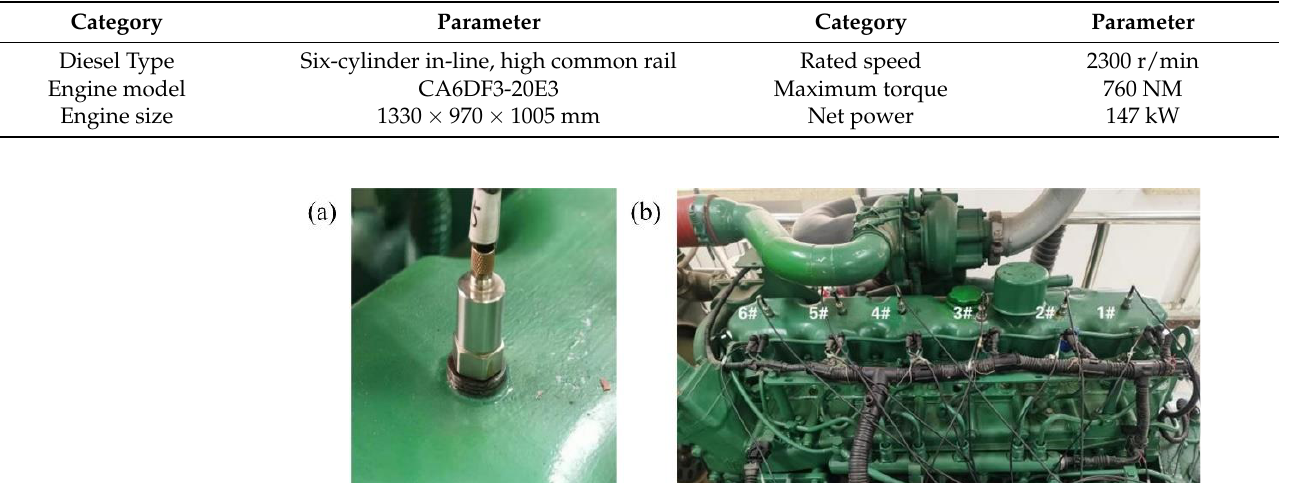
Table 2. Basic parameters of diesel engine.